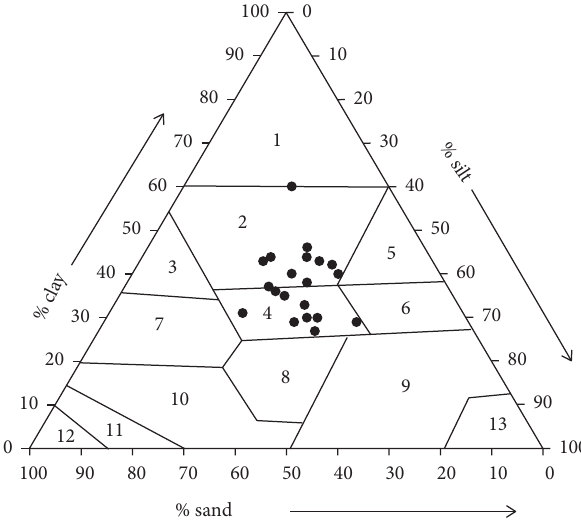
Figure 3: Textural classes of the Bamenda Gleysols according to the United States Department of Agriculture textural classi- fication—classification according to the Soil Science Division